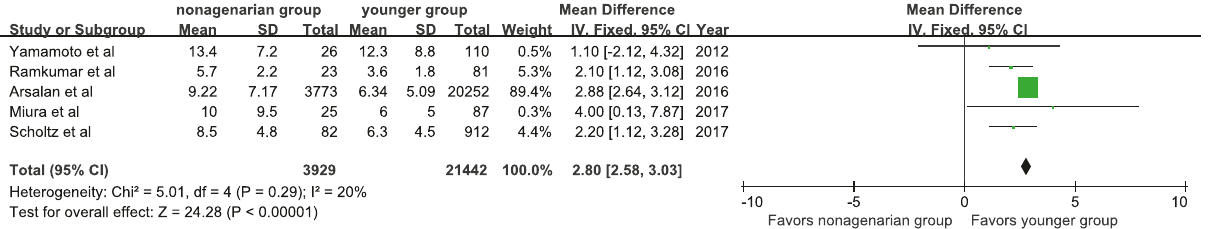
in the younger group. Nonagenarians were associated with a significantly higher 1-year mortality (OR, 1.39; 95%CI: 1.26, 2 =0%, Figure 1.53; I